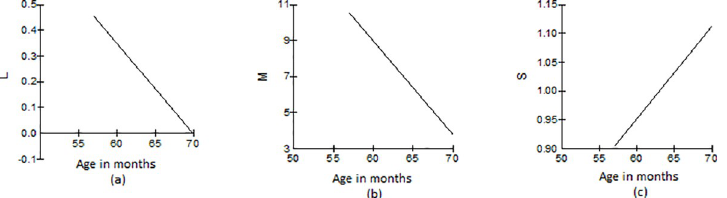
Fig 3. The L,M,S curves. Individual description of how the skewness coefficient (L), median (M), and variation (S) vary with time.